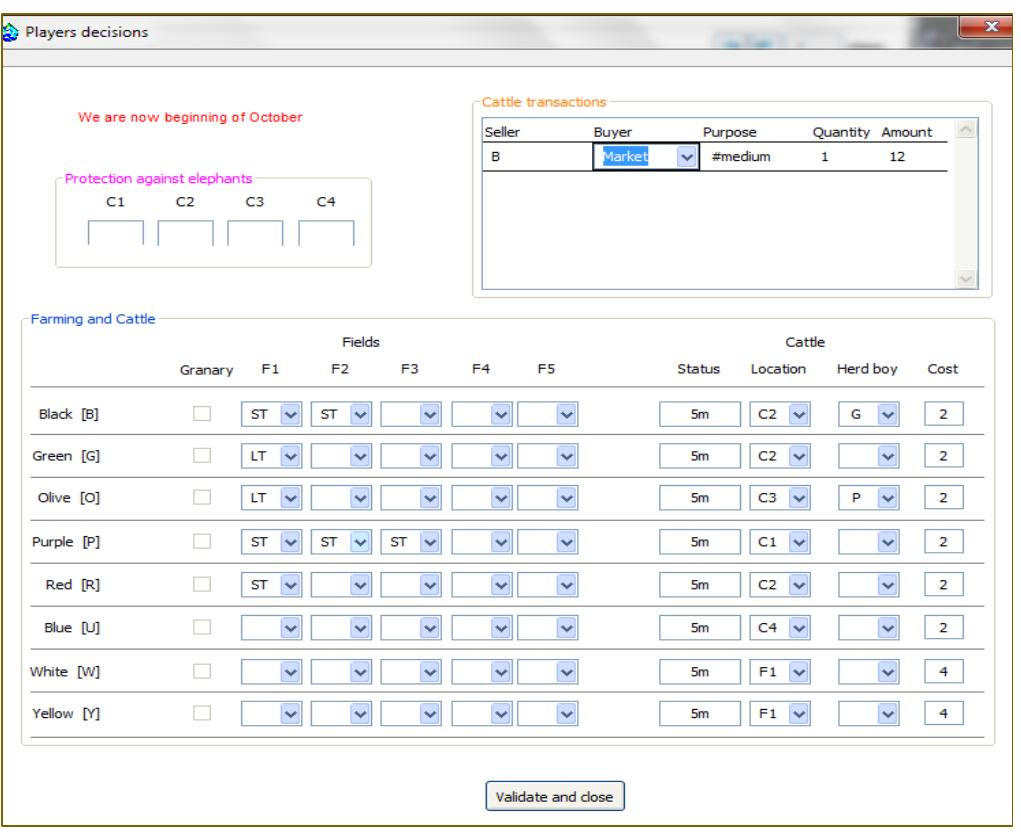
Figure 5.4. Interface used by the computer operator to enter players’ decisions at the beginning of each month . The “protection against elephants” can be filled with the initials of the players paying to protect a communal GrazingArea (in this case no one protected any). The “cattle transaction” box deals with cattle sales and purchases (here the Black player sold a medium cow to the market and earned 12ST). The “Farming and Cattle” relates to crops and cattle herding. Here for instance, the black players decided to plant two of his fields with short-term maize and to put his Cattle -guarded by the Green herdboy- in